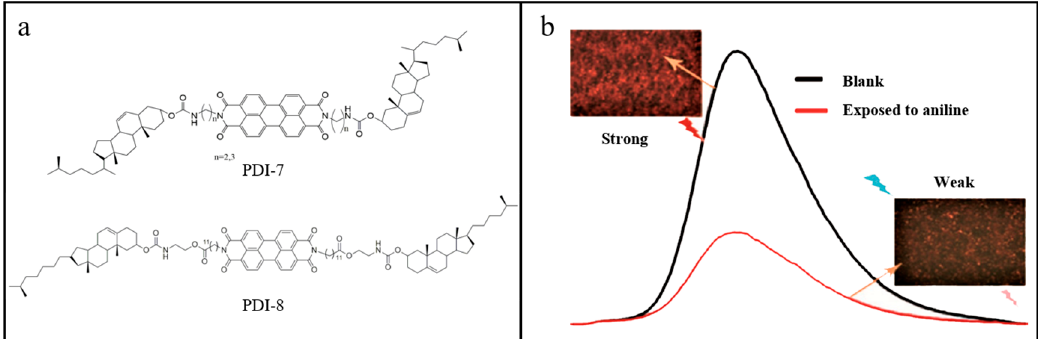
Figure 9. ( a ) Molecular structures of building blocks PDI-7 and PDI-8; ( b ) Fluorescence spectra of nanofibers film of PDI-7 in the absence and presence of aniline vapor, with inset showing the photographs taken on the corresponding films [68,69].